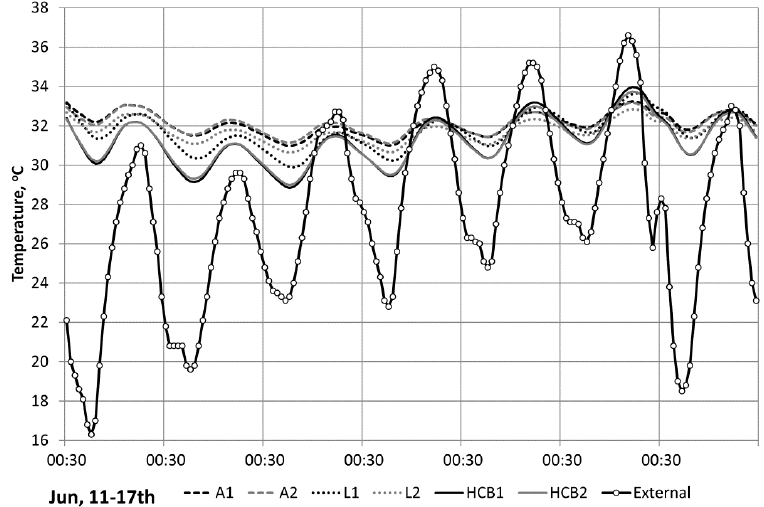
Figure 6. Outdoor temperature and indoor room temperatures for different wall constructions, for a seven day summer